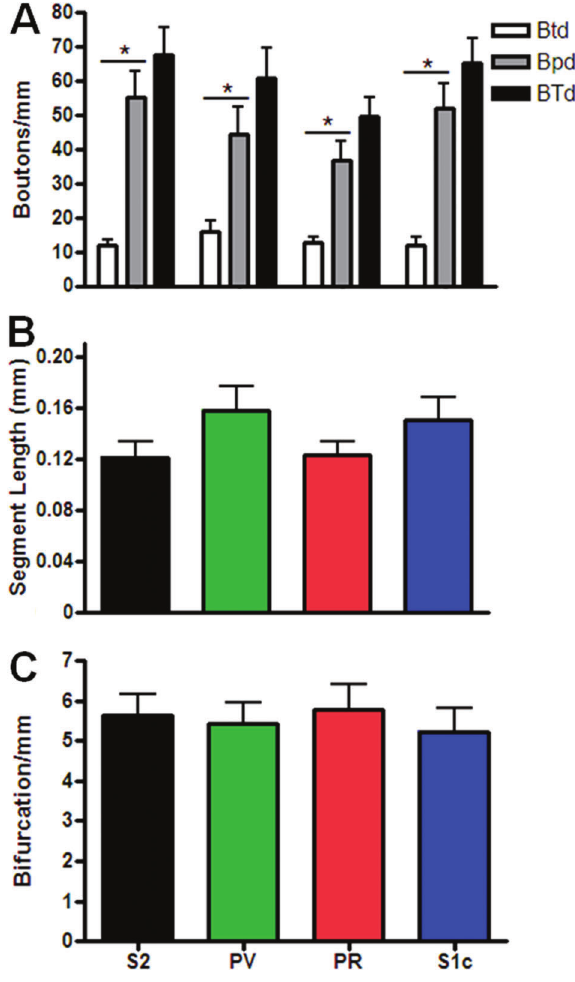
Figure 3 . Multivariate discriminant statistical analysis shows that the linear density per millimeter of en passant boutons (Bpd) was higher than that of terminaux boutons (Btd) (*P o 0.05, Bpd vs Btd; ANOVA-Tukey post hoc test) in all cortical target areas ( A ). BTd: Bpd + Btd. Axon terminals in secondary somatosensory area (S2), parietal rhinal area (PR), parietal ventral area (PV) and contralateral primary somatosensory area (S1c) presented similar morphological components (P 4 0.05) based on segment length per millimeter ( B ) or bifurcation density per millimeter ( C